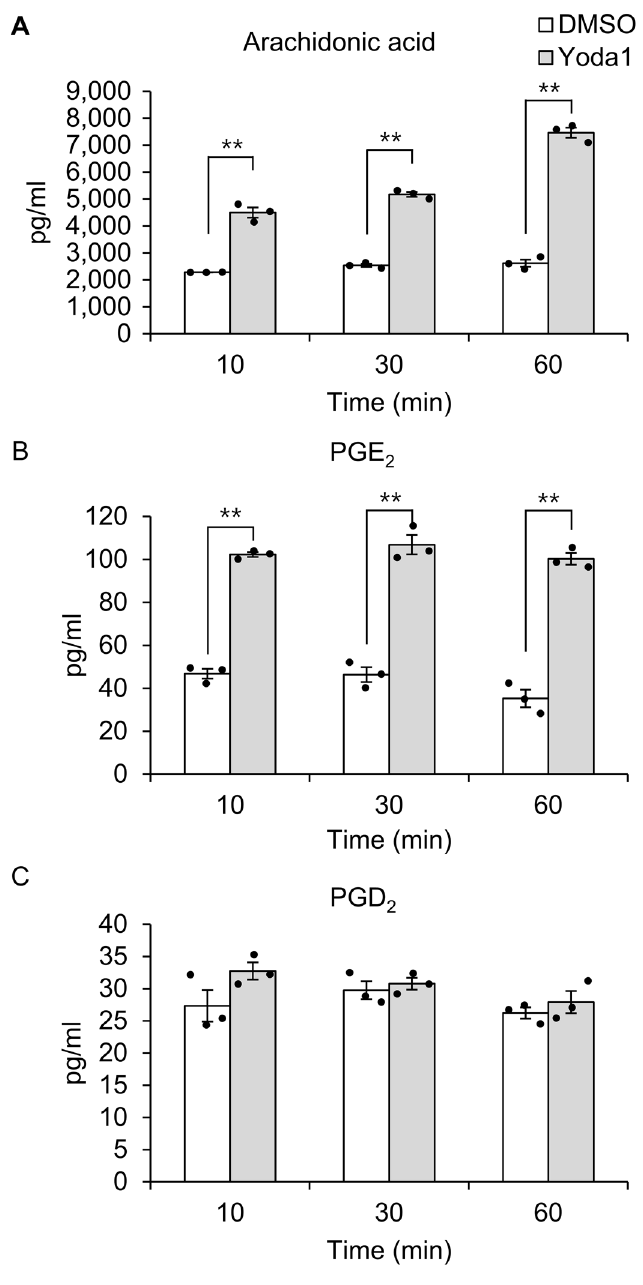
Figure 6. Direct activation of Piezo1 by Yoda1 induces the release of arachidonic acid and PGE 2 in human trabecular meshwork cells. Human trabecular meshwork cells were incubated for the indicated time with or without Yoda1, and lipid mediators in the medium were analyzed. Yoda1 triggered the release of arachidonic acid ( A ) and PGE 2 ( B ), but not PGD 2 ( C ) in human trabecular meshwork cells. Data are expressed as the means ± SE (n = 3 samples of lipid mediators extracted from cell supernatant in 3 chambers). ** p < 0.01, two- tailed Student’s t